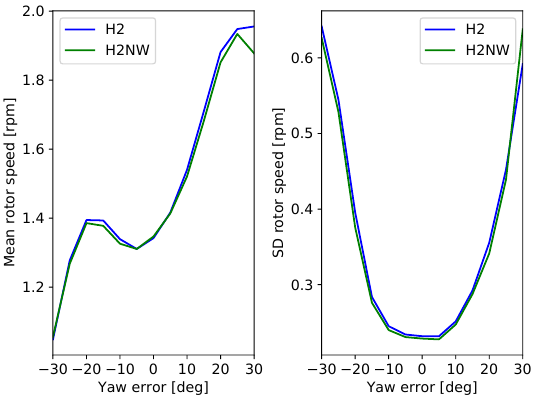
Figure 14. Mean and standard deviation of the idling rotor speed. The near-wake model slightly reduces mean idling rotor speed as well as its standard deviation, which is consistent with the generally lower flapwise loading predicted by HAWC2